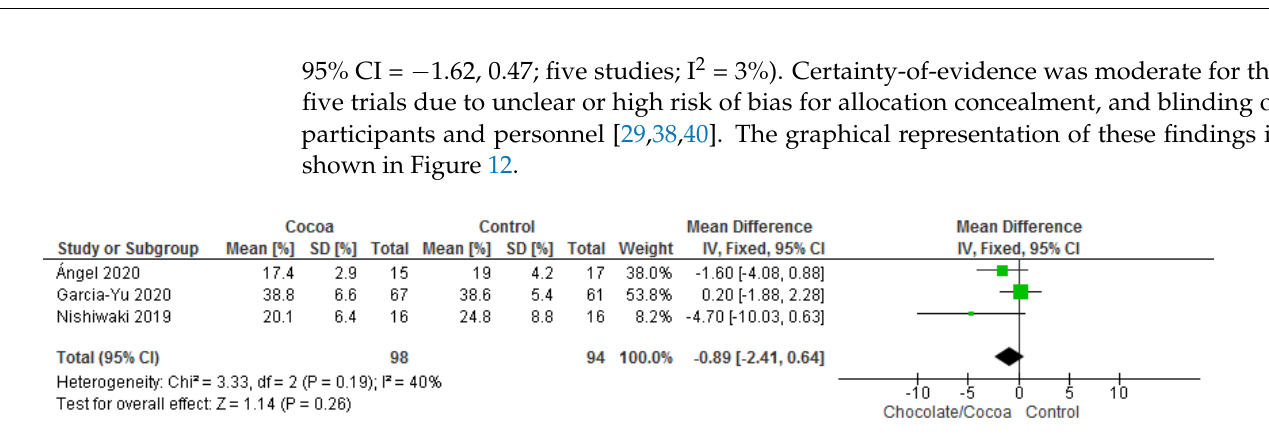
Figure 11. Forest plot of comparison: chocolate versus control, with the outcome - waist circumference (cm).